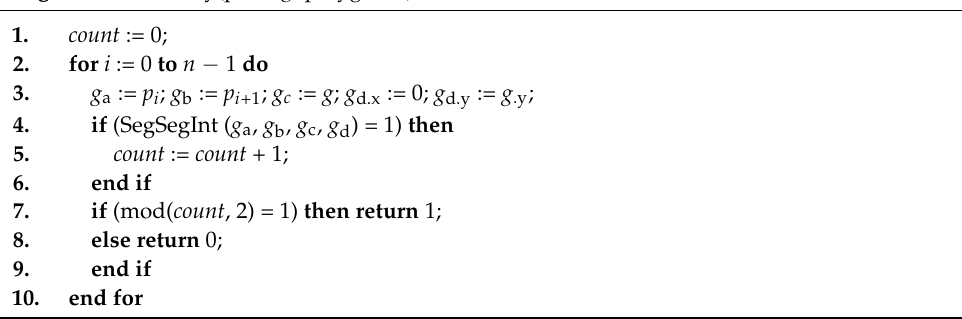
Algorithm 2. PtInPy(point g , polygon P